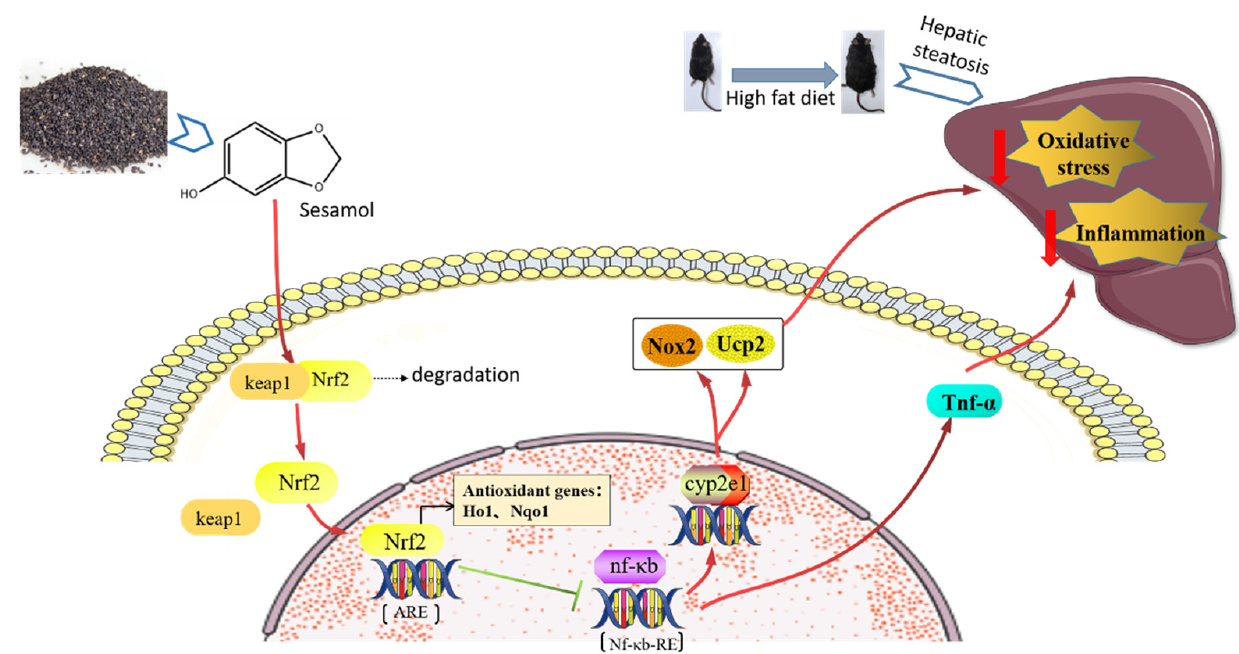
Figure 7. SEM alleviated HFD-induced hepatic steatosis by reducing oxidative stress and inflammation in the liver via activating Nrf2 transcription.